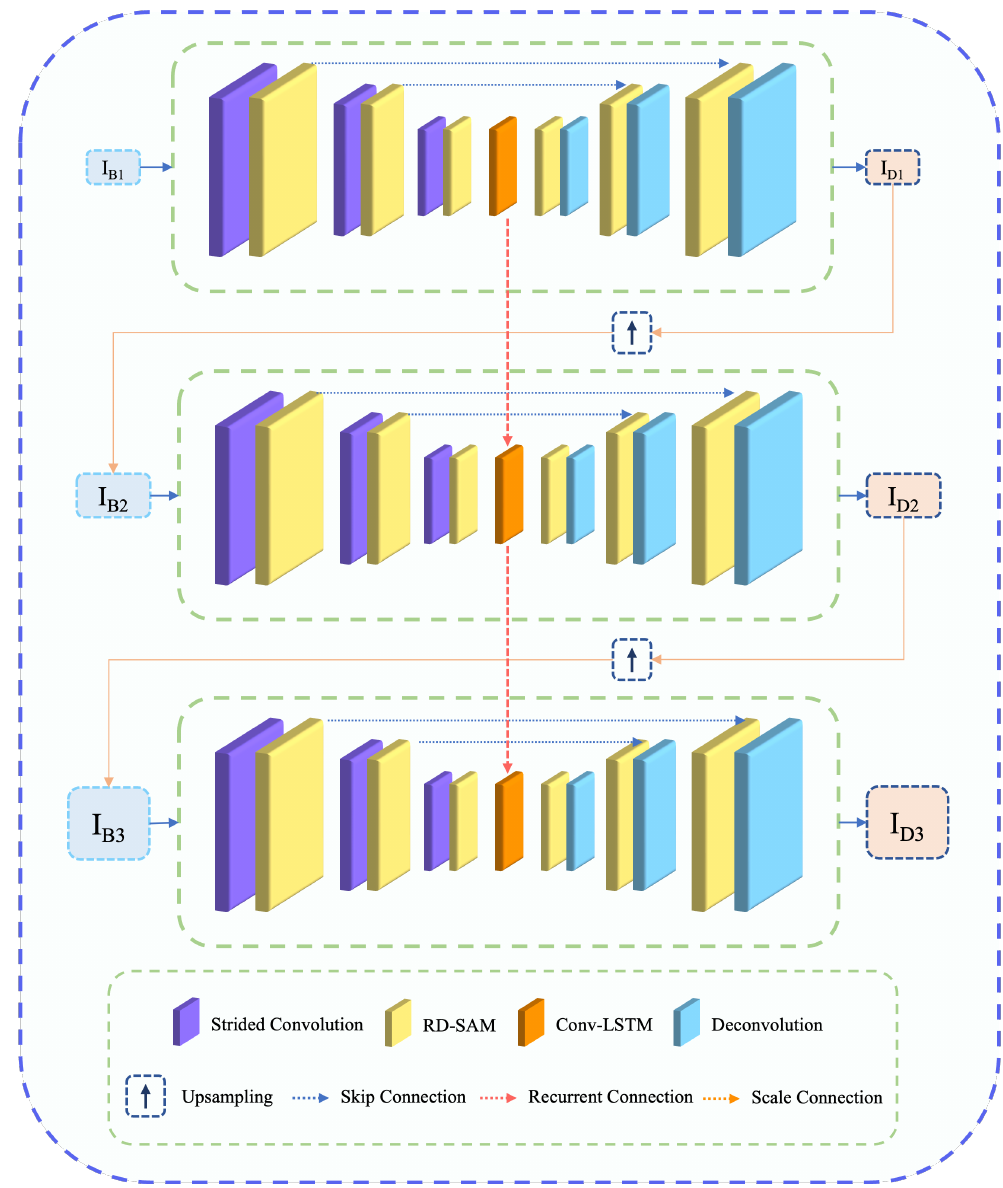
Figure 2. Overview of the proposed network for learning medical image deblurring. The proposed method comprises a novel RD-SAM block in a scale recurrent network for learning salient features to accelerate deblurring